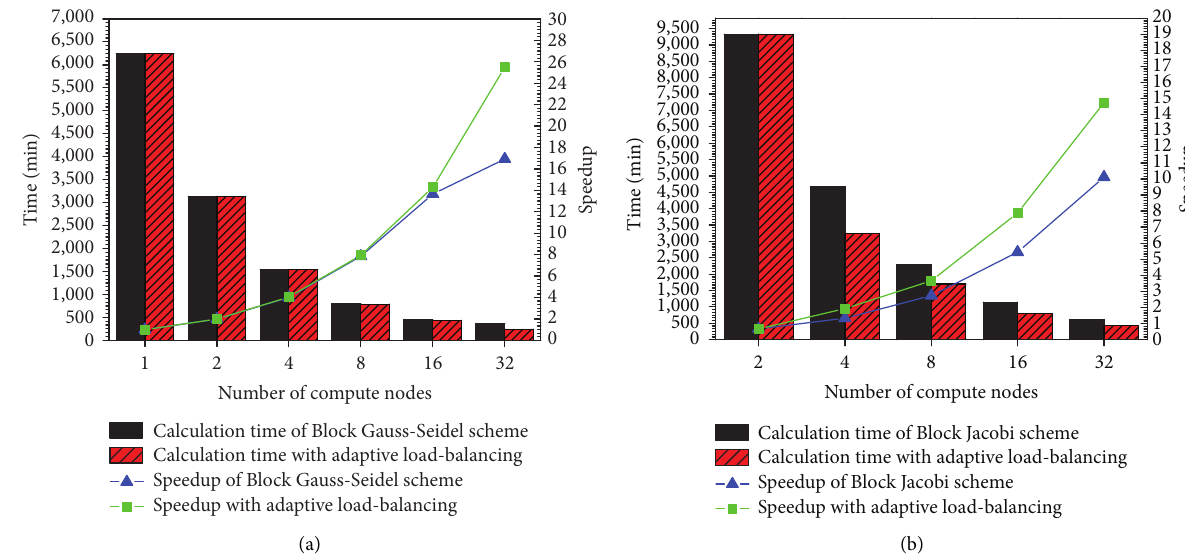
Figure 14: Total running time and speedup of the two schemes for 1000MWt metallic fuel core benchmark with different number of compute nodes. (a) Block Gauss–Seidel scheme. (b) Block Jacobi scheme.